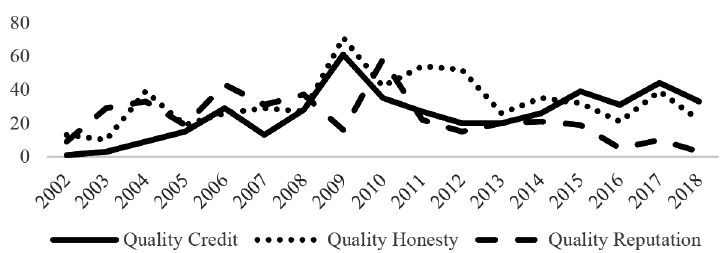
Figure 1. Number of quality credit essays in Chinese